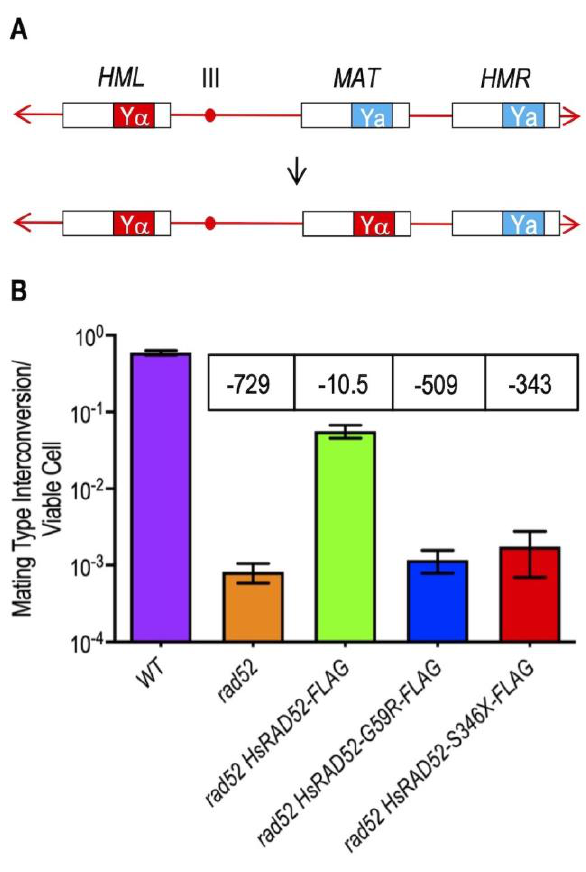
FIGURE 3: The adh1::HsRAD52-G59R-FLAG and adh1::HsRAD52- S346X-FLAG alleles do not suppress the MTI defect of rad52 mutant yeast cells. (A) Cartoon depicting MTI. DSB formation by HO endonuclease cutting at the HO cut site on the centromere distal edge of the Ya sequence (blue box) at the MAT locus on chromosome III precipitates the exonucleolytic removal of “a” mating type information prior to its replacement by unidirectional transfer of “ ⍺ ” mating type information from the Y ⍺ sequence (red box) of the flanking, intact but silent HML locus. This results in the switching of the cell from the “a” mating type to the “ ⍺ ” mating type. (B) The adh1::HsRAD52-G59R-FLAG and adh1::HsRAD52- S346X-FLAG alleles confer defects in MTI. Single colonies of hap- loid wild-type (ABX3817-15B), rad52 (ABX3817-7D), rad52 adh1::HsRAD52-FLAG (ABX3977-10C), rad52 adh1::HsRAD52- G59R-FLAG (ABX3985-55B), and rad52 adh1::HsRAD52-S346X (ABX3994-18D) strains were used to inoculate at least 10 one milliliter YPGL cultures and grown overnight. Following a period of expression of HO endonuclease, appropriate dilutions were plated onto YPD medium, incubated for three days at 30°, and the num- ber of colonies counted. Colonies were replica plated to fresh YPD plates, printed with a lawn of the haploid R113a mating type test- er strain, printed plates incubated overnight at 30°C and then replica plated onto SD plates, which were incubated overnight at 30°C. Frequencies of MTI were determined by dividing the number of diploid patches arising on the SD plates by the number of colo- nies counted on the original YPD plates. Mean frequencies of MTI and 95% confidence intervals were plotted against genotype. Fold differences below (-) the wild-type frequency of MTI for each strain are indicated in boxes above the bar for each mean fre-